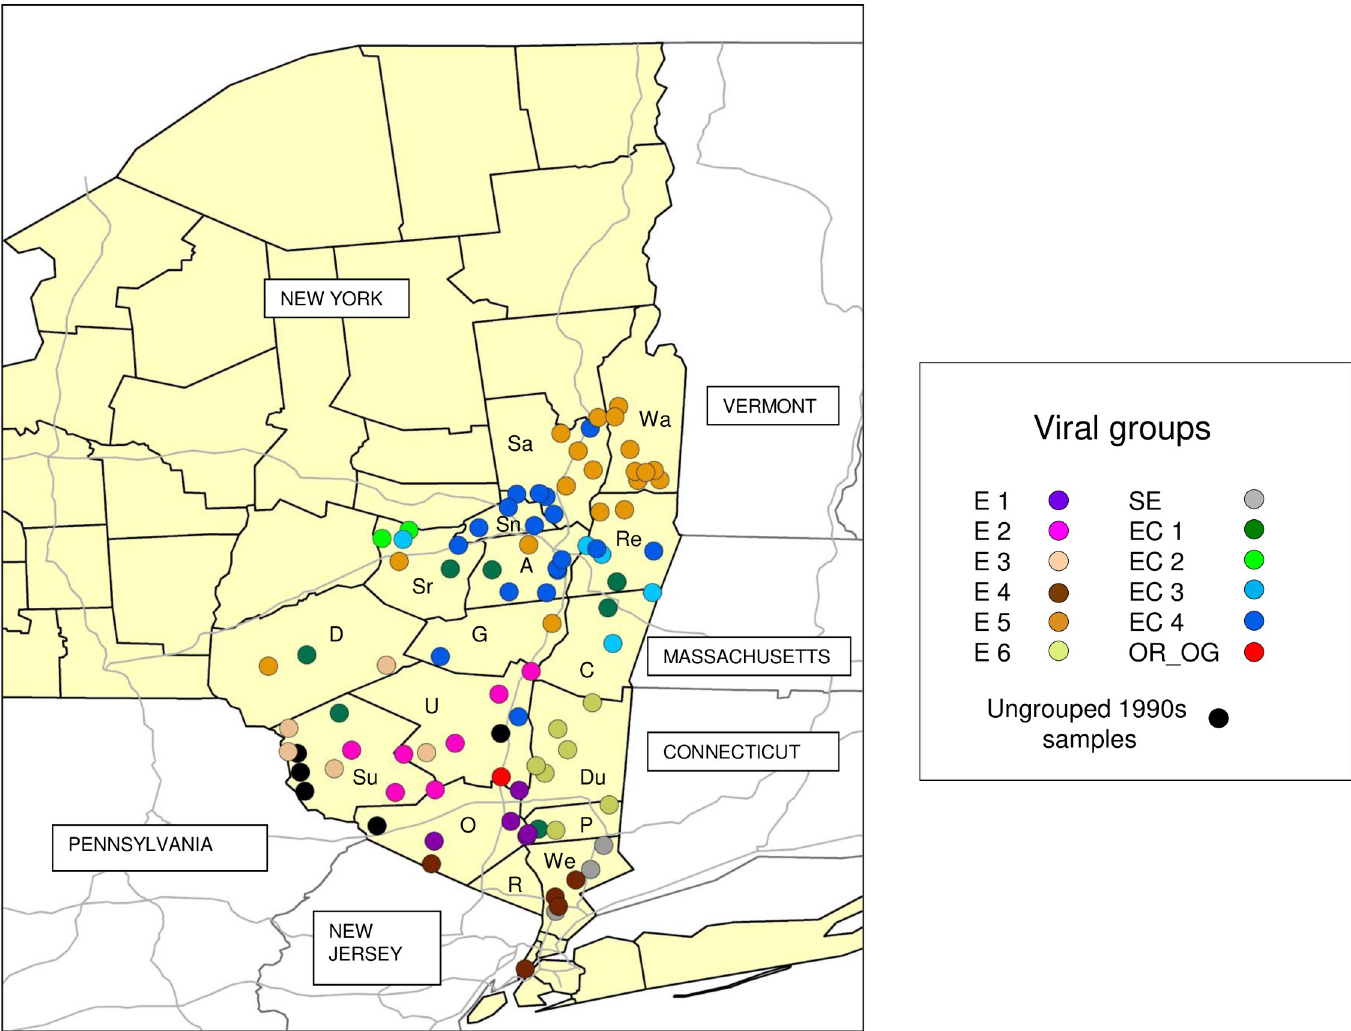
Fig 4. Distribution of the RRV variants of southeastern New York. Isolates are color-coded as shown in the legend and as per Fig 3. The New York counties in the target region are shown in beige with black boundaries and are identified as follows: those in the Capital District include Albany (A), Columbia (C), Greene (G), Rensselaer (Re), Saratoga, (Sa), Schenectady (Sn), and Washington (Wa); those in the Hudson Valley which runs north-south and separates the easternmost counties of Dutchess (Du), Putnam (P) and Westchester (We) from western counties Orange (O), Rockland (R), Sullivan (Su) and Ulster (U). The counties of Delaware (D) and Schoharie (Sr) are located further west in neighboring zones. Main highways are shown in grey and bordering states are